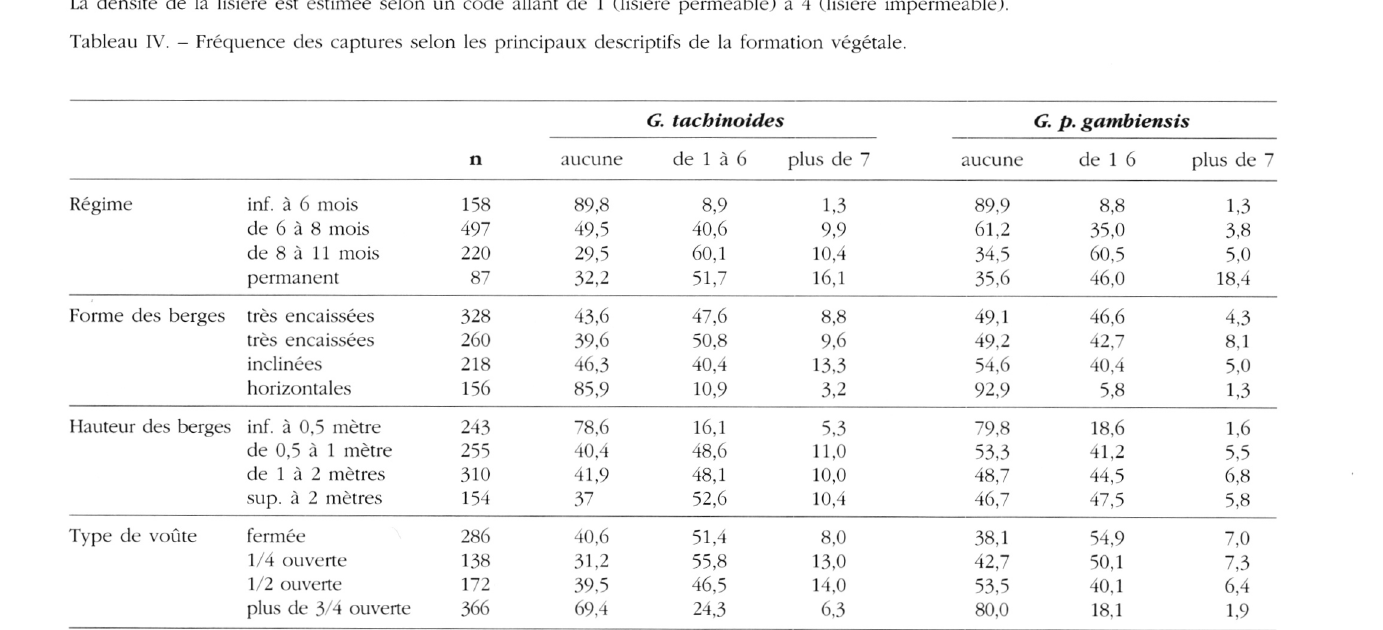
Ces différentes classes de typologies, aisément